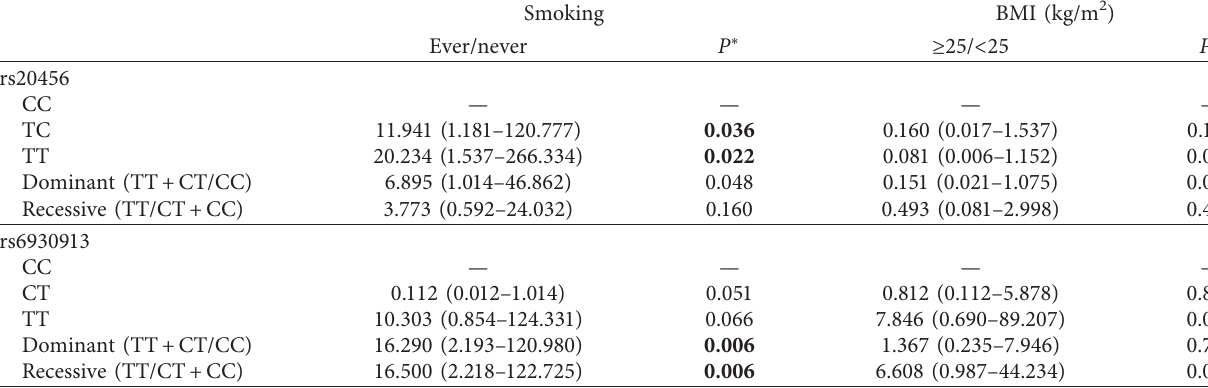
Table 4: Gene-environmental interactions on the risk of hypertension.